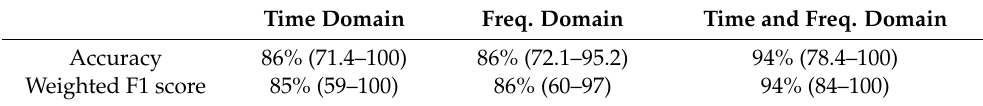
Table 5. Summary of experiments: mean and range of the testing set. Time Domain Freq. Domain Time and Freq.